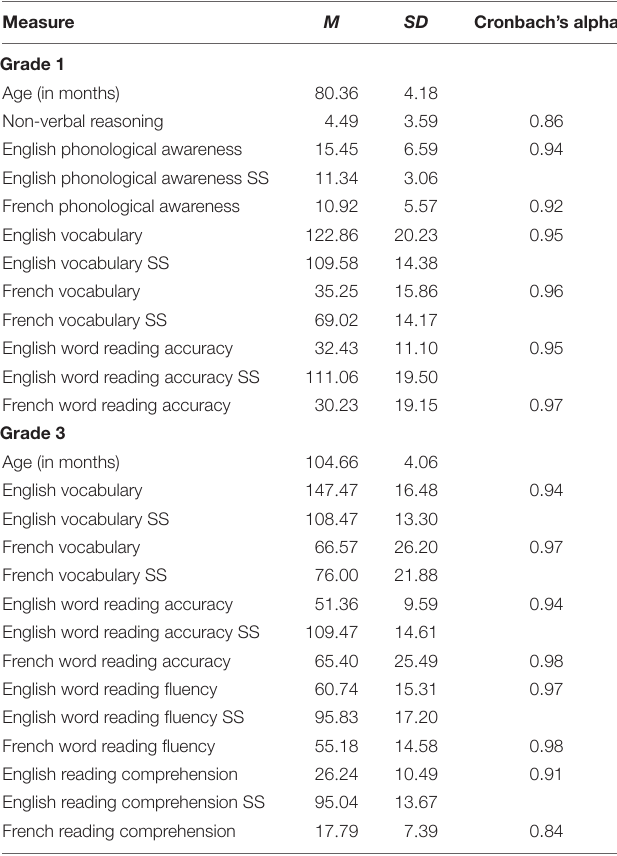
TABLE 1 | Means, standard deviations, and reliabilities for the total sample ( N = 180) on English and French measures in grade 1 and grade